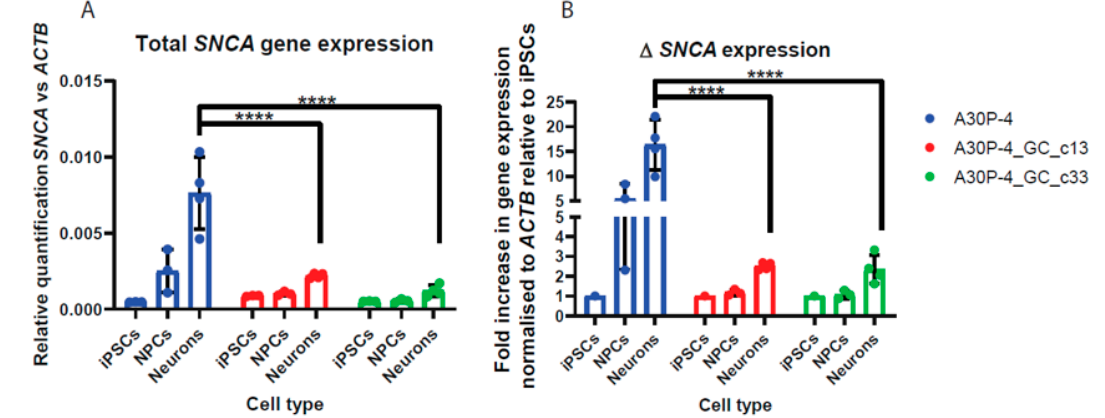
Figure 8. Change in SNCA expression in iPSCs, NPCs and neurons. ( A ) Relative quantification of SNCA mRNA expression across multiple cell lines. ( B ) Fold change in gene expression relative to iPSCs. An ordinary 2-way ANOVA statistical test was performed with Tukey’s multiple comparison post-hoc test. **** p < 0.0001.